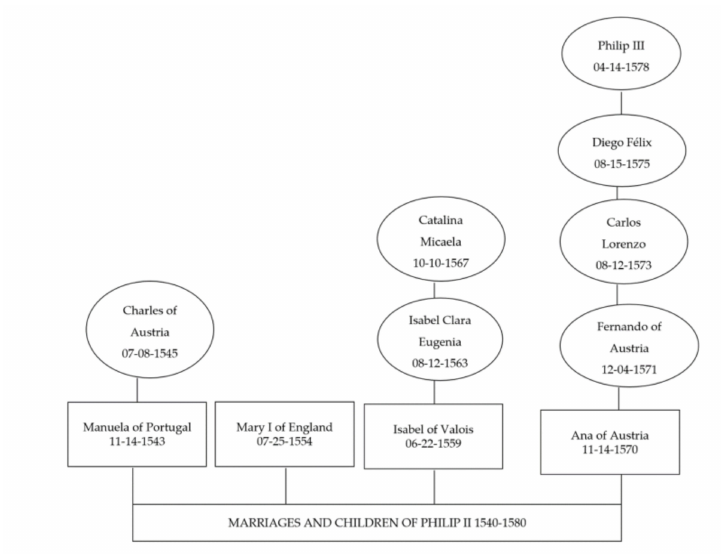
Figure 2. Women and children of Philip II (1540–1580). Source: authors’ own